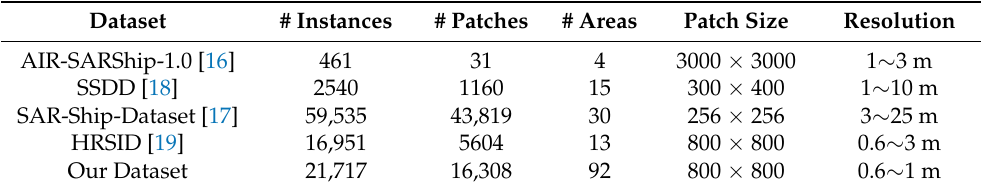
Table 1. Comparison of statistics among multiple datasets. We denote the number of instances, patches, and areas as # Instances, # Patches, and # Areas,